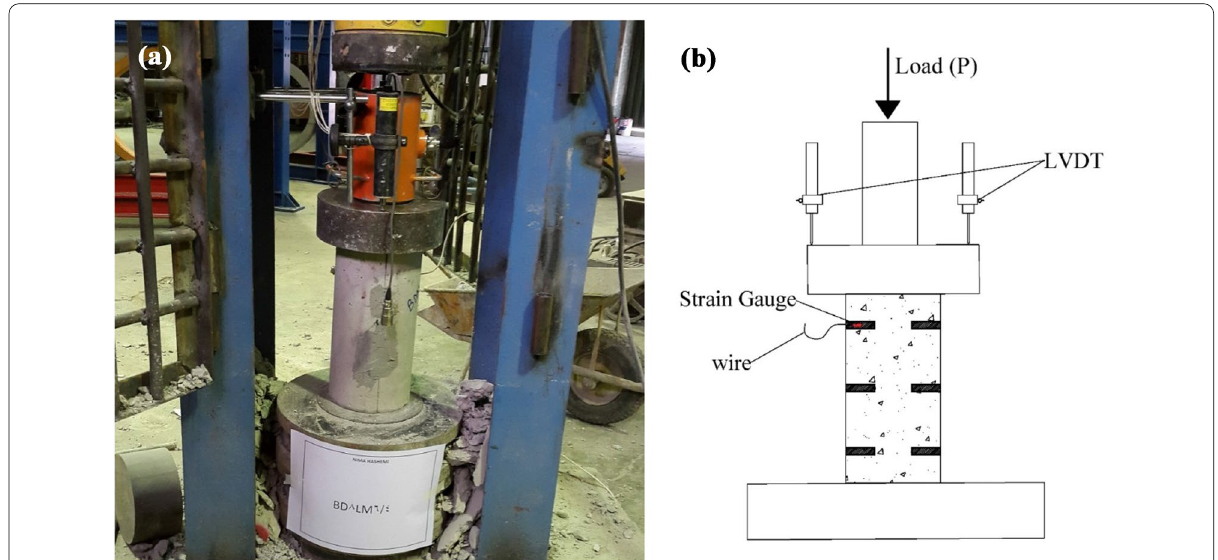
Fig. 4 The position of LVDT and load cell on concrete specimen: a experimental, and b schematic of test configuration.